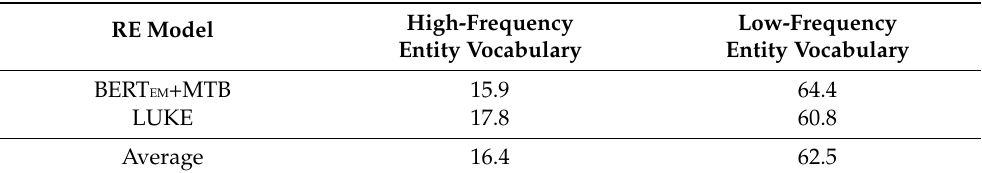
Table 8. Comparison of violation rates (%) of high-frequency entity vocabulary and low-frequency entity vocabulary replacement in MR-R 1